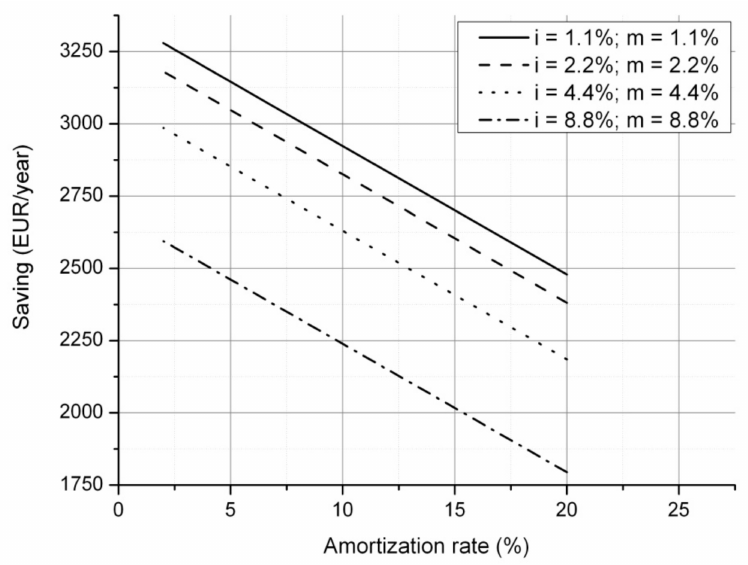
Figure 5. Dependence of the amortization rate on savings for various values of i—interest rate and m—service